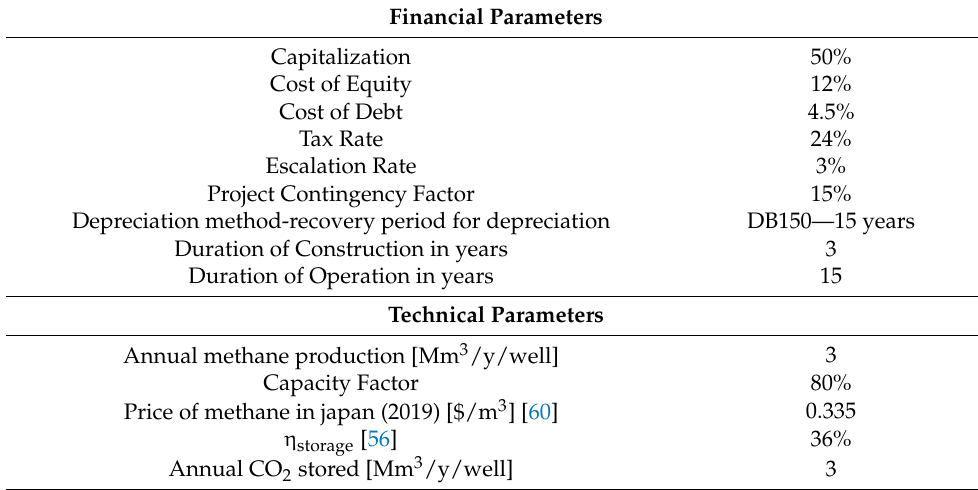
Table 7. The financial and technical parameter to evaluate the CO 2 storage